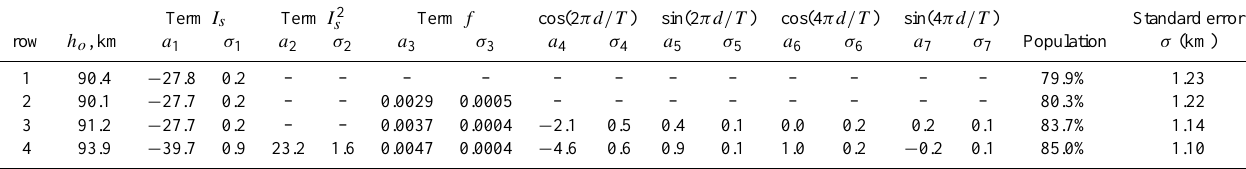
Table 1. Coefficients of the empirical model for the peak altitude of the OH nightglow emission at Longyearbyen. Row 4 gives the coefficients for the empirical formula relating the SABER OH IER, I s , to the peak altitude of the OH layer. Term I s Term I 2 s Term f cos(2 πd/T ) sin(2 πd/T ) cos(4 πd/T ) sin(4 πd/T ) Standard error row